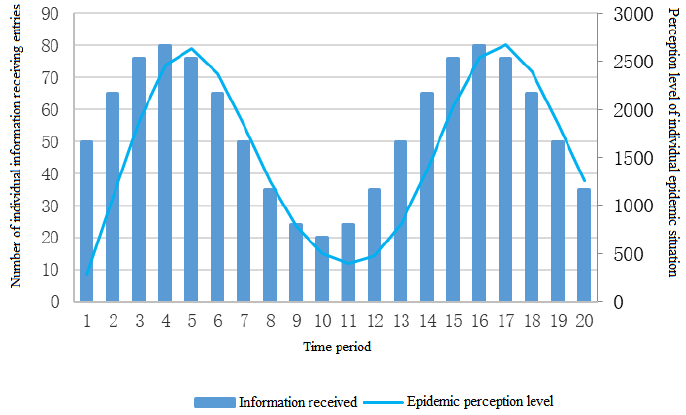
Figure 6. Changes of the risk perception when the individual information receipts fluctuate. According to Figure 6, after excluding the proportion of negative/positive infor- mation, the “lag phenomenon” exists between the total amount of t he positive individual information acceptance and the individual epidemic perception.